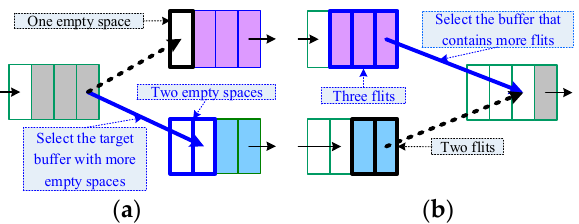
Figure 6. ( a ) Congestion avoidance selects a target buffer with more empty space and ( b ) congestion relief selects a source buffer with more flits.